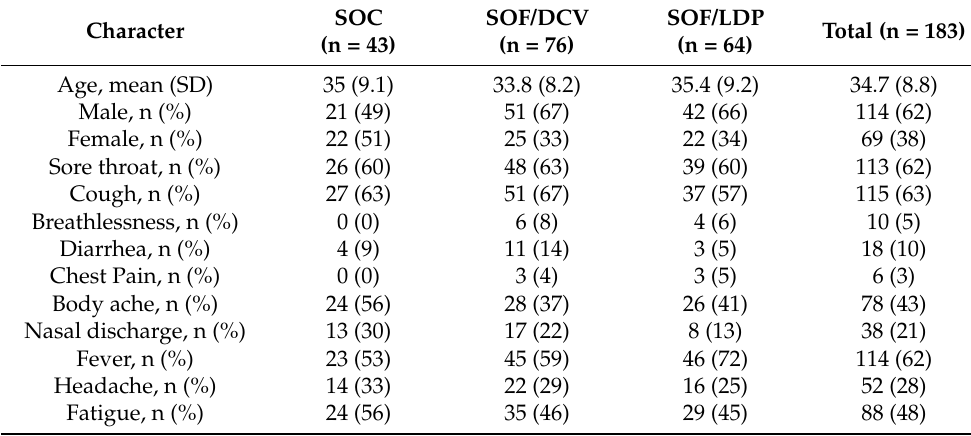
Table 1. Baseline characteristics of the study participants.